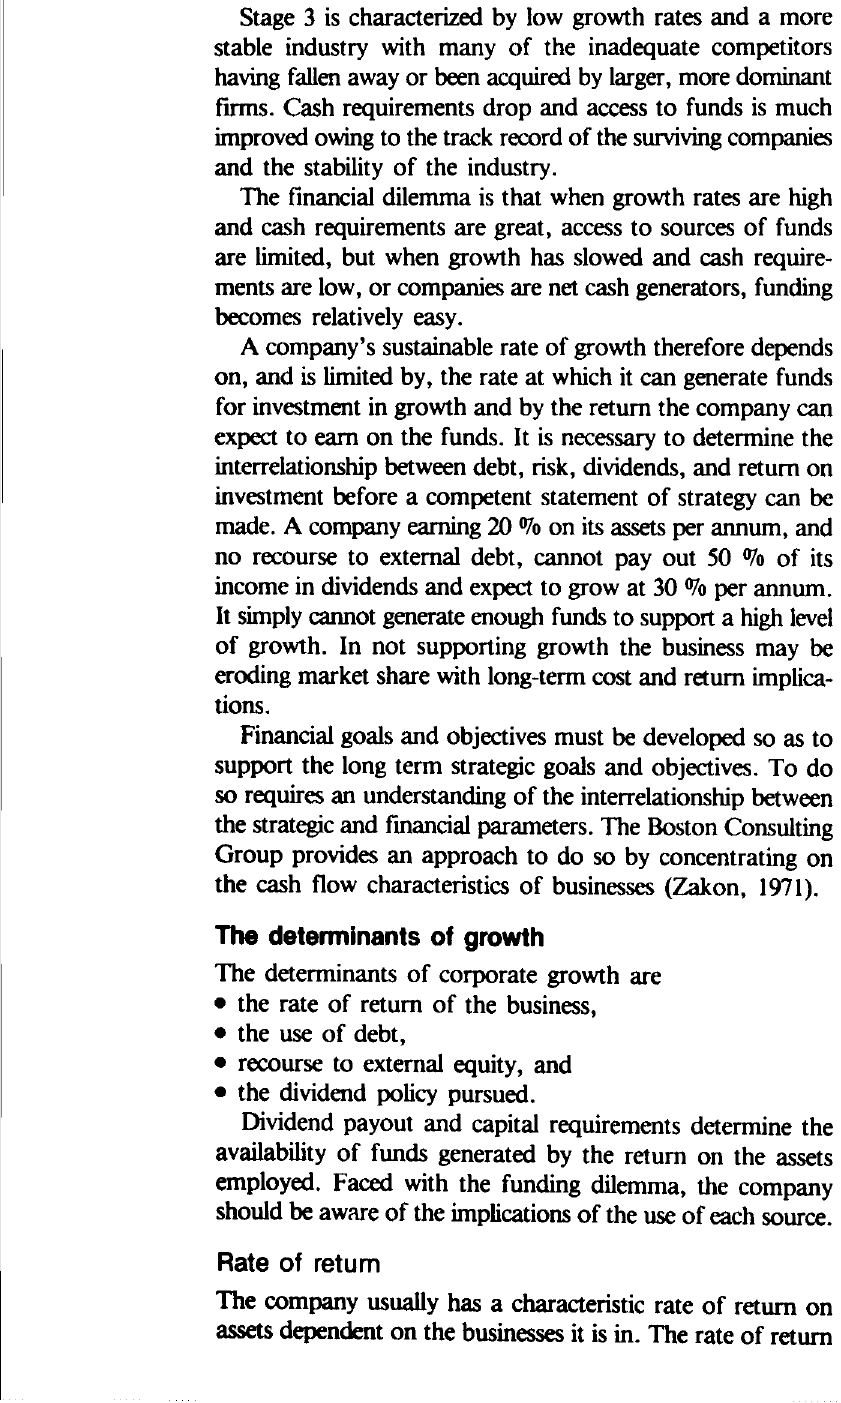
Figure 1 Growth and financial strategy across the product life cycle (Robinson,